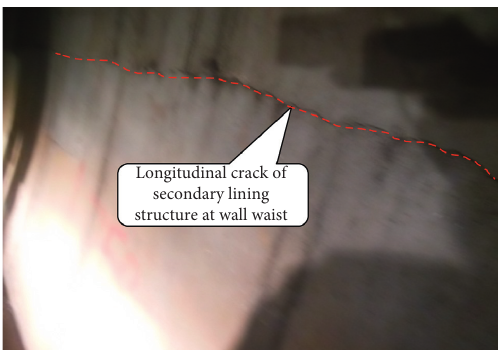
Figure 14: Longitudinal crack of secondary lining structure at wall waist.